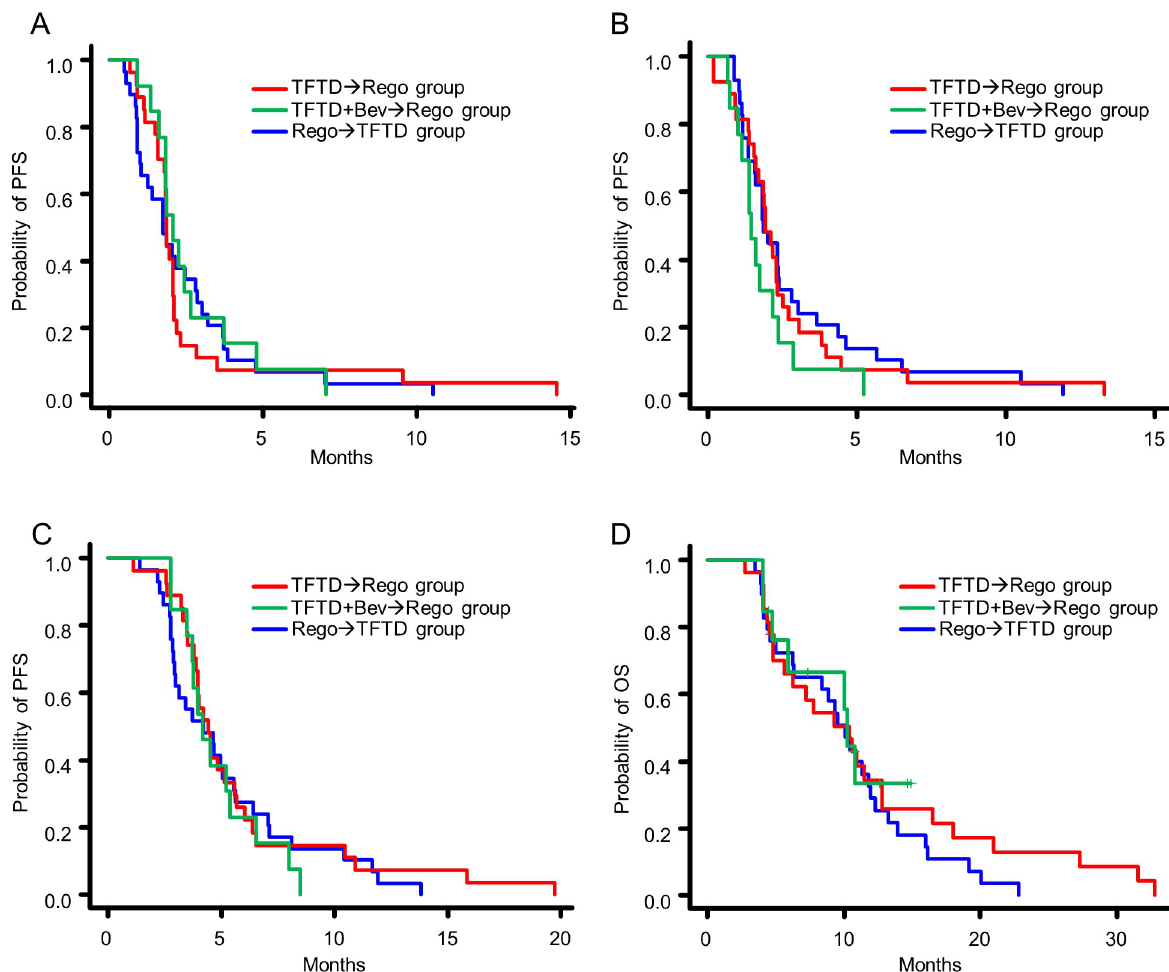
Fig 2. The efficacy of each agent and three groups. Kaplan-Meier plots of the (A) progression-free survival (PFS) after precedent and subsequent regorafenib therapy; (B) PFS after precedent and subsequent TFTD therapy; (C) PFS after sequential treatment with the two drugs (T-PFS); (D) overall survival